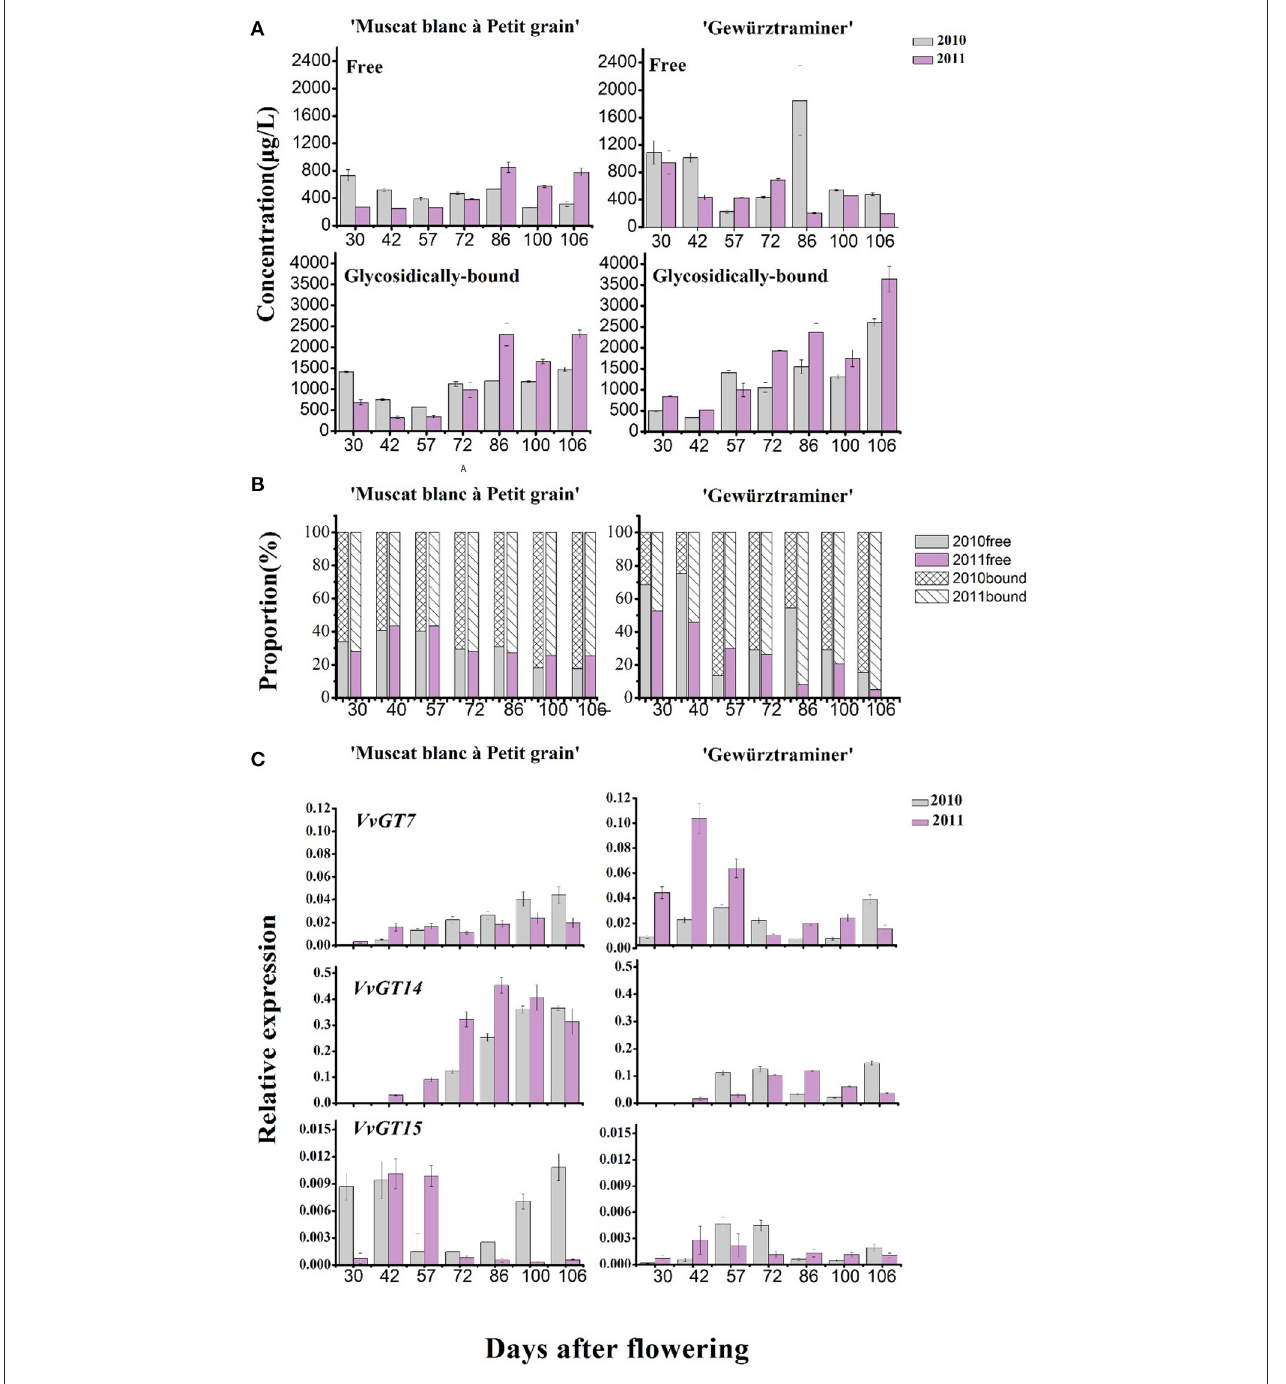
FIGURE 3 | (A) Changes of the total concentrations of free-form (first line) and glycosidically bound (second line) monoterpenes along with grape berry maturation. (B) The percentage of free and glycosidically-bound concentrations, respectively, to the total. (C) Relative expression amount of three genes coding for monoterpenyl glycosyltransferases in developing “Muscat blanc à Petit” and “Gewurztraminer” berries in 2010 and 2011.